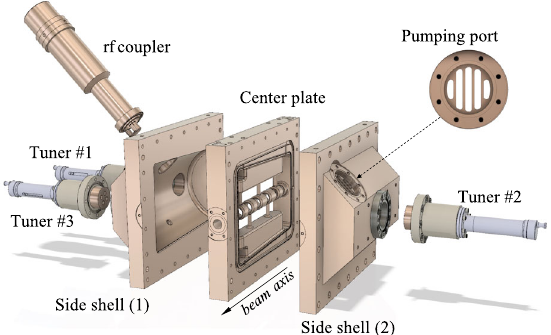
FIG. 2. Mechanical structure of the short